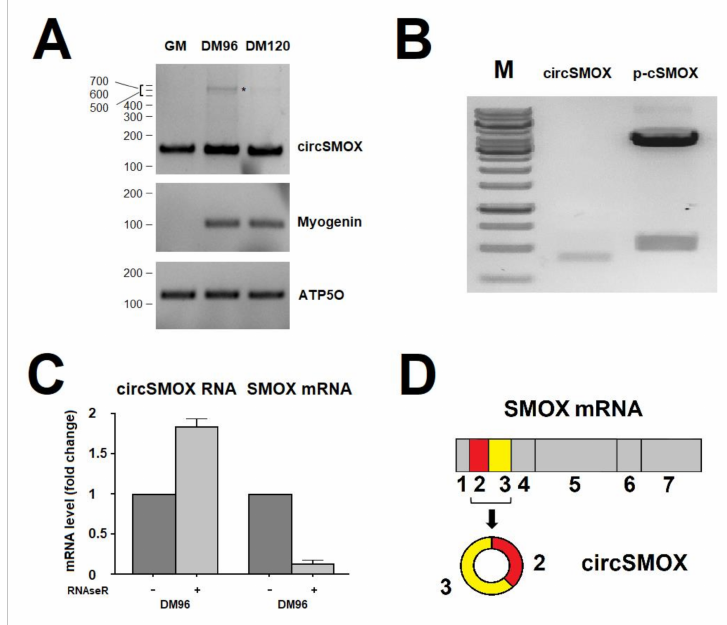
Figure 1. Evaluation of the existence of a circular RNA for SMOX. ( A ). RT-PCR analysis on murine C2C12 myoblasts (GM) and myotubes (DM) at di ff erent time points (DM 96 and DM 120) using primers circSMOX1-circSMOX 2 to amplify the circSMOX back splicing junction. The expected molecular